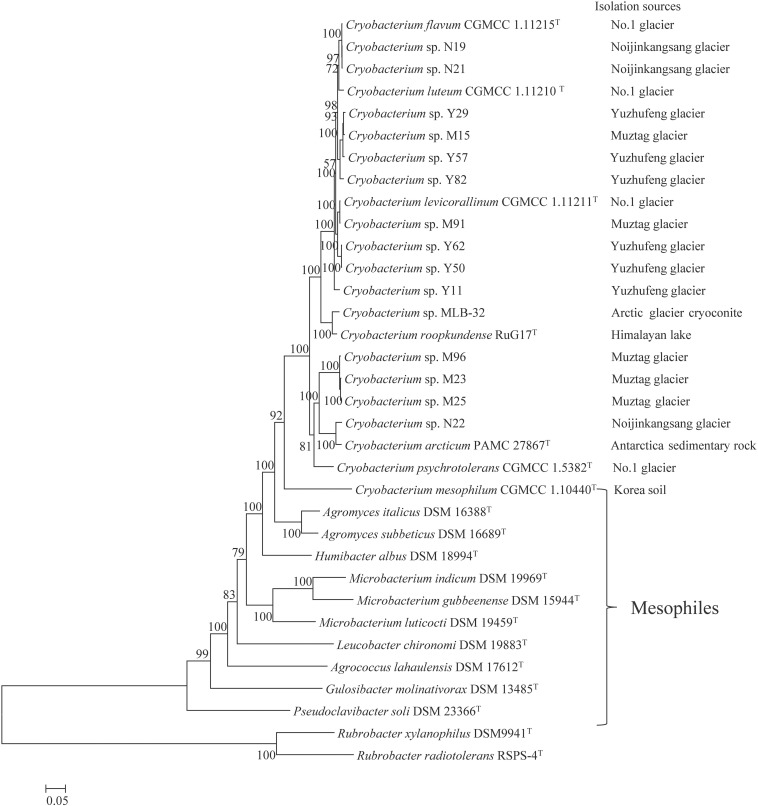
Phylogenetic clustering of 32 Microbacteriaceae strains. Phylogeny is based on concatenated alignment of 74 orthologous proteins with 1,000 bootstraps using RAxML. Rubrobacter xylanophilus DSM9941 and R. radiotolerans RSPS-4 were used as out-groups. Bar represents accumulated changes per amino acid.